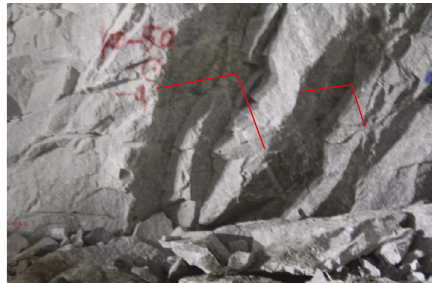
Figure 23: Damage of the top arch joint of the upstream side wall in the K0 +100m of the pilot tunnel in the main powerhouse.